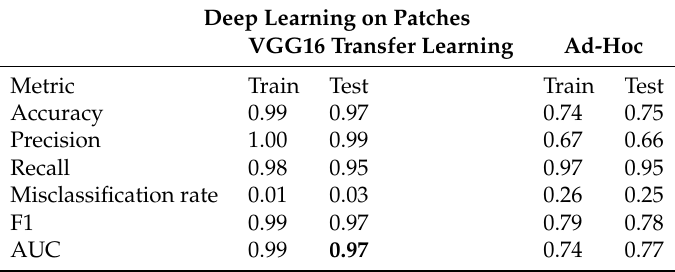
Table 5. Deep Learning Accuracy using